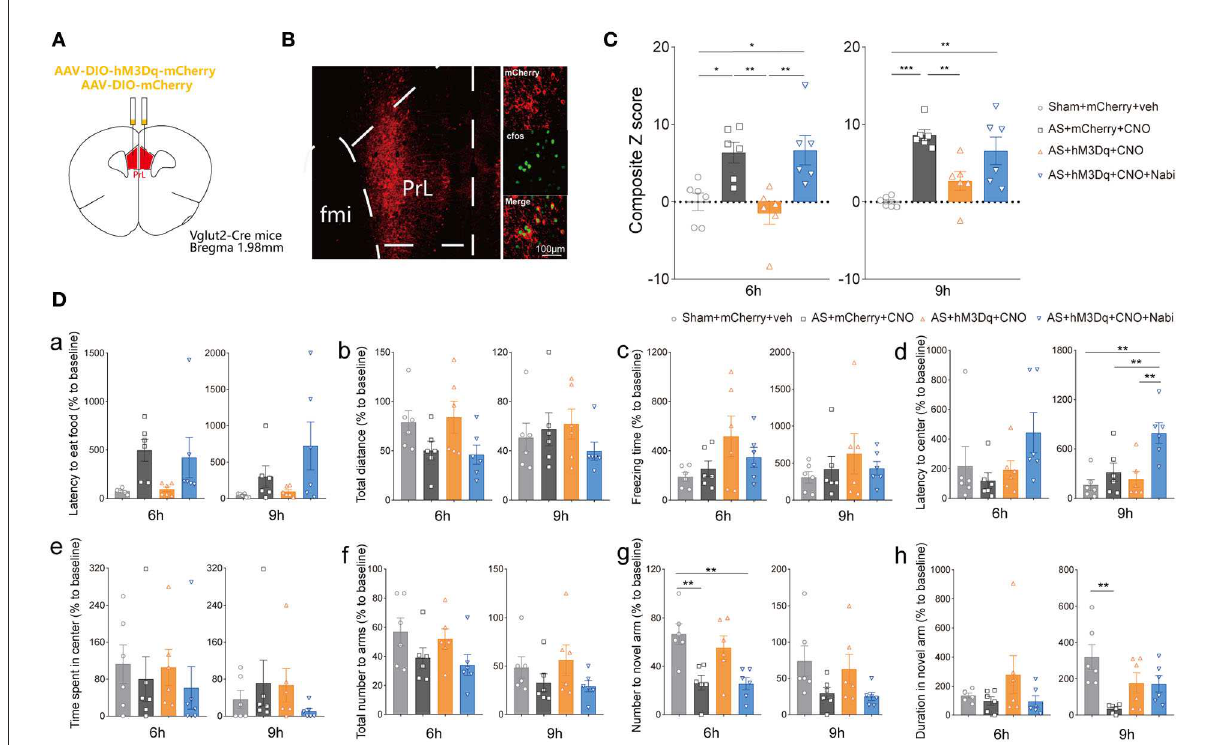
FIGURE4 eCB signaling modulated POD through the PrL glutamatergic neurons. (A) Scheme of hM3Dq or control virus injection into the PrL of Vglut2-Cre mice. (B) The injection site (left) and activation efficiency (right). (C) The composite Z score at 6h (left) and 9h (right) after AS. (D) The latency to eat food in buried food test (a); the total distance (b), the freezing time (c), the latency to center (d), time spent in center (e) in the open field; the total number to arm (f), number to novel arm (g), duration in the novel arm (h) in Y maze at 6h (left) and 9h (right) after AS. Data are shown as mean ± SEM. N = 6. * P < 0.05, ** P < 0.01, *** P < 0.001. ISO, isoflurane; AS, anesthesia and surgery; Nabi, nabilone; CNO, clozapine N-oxide; mCherry, AAV-DIO-mCherry; hM3Dq,